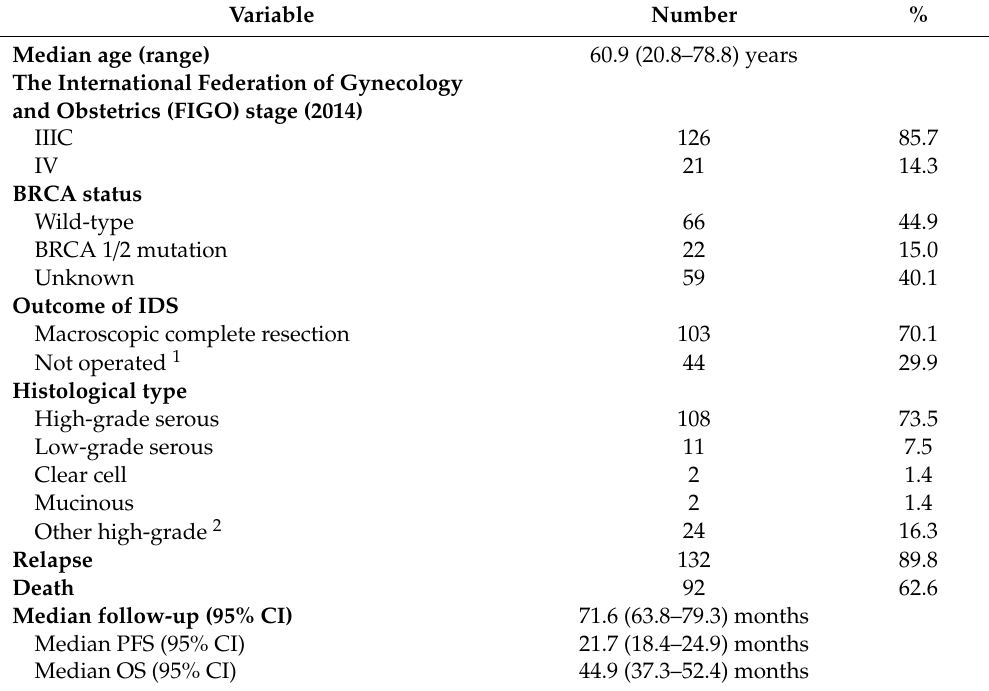
Table 2. Patients’ characteristics.